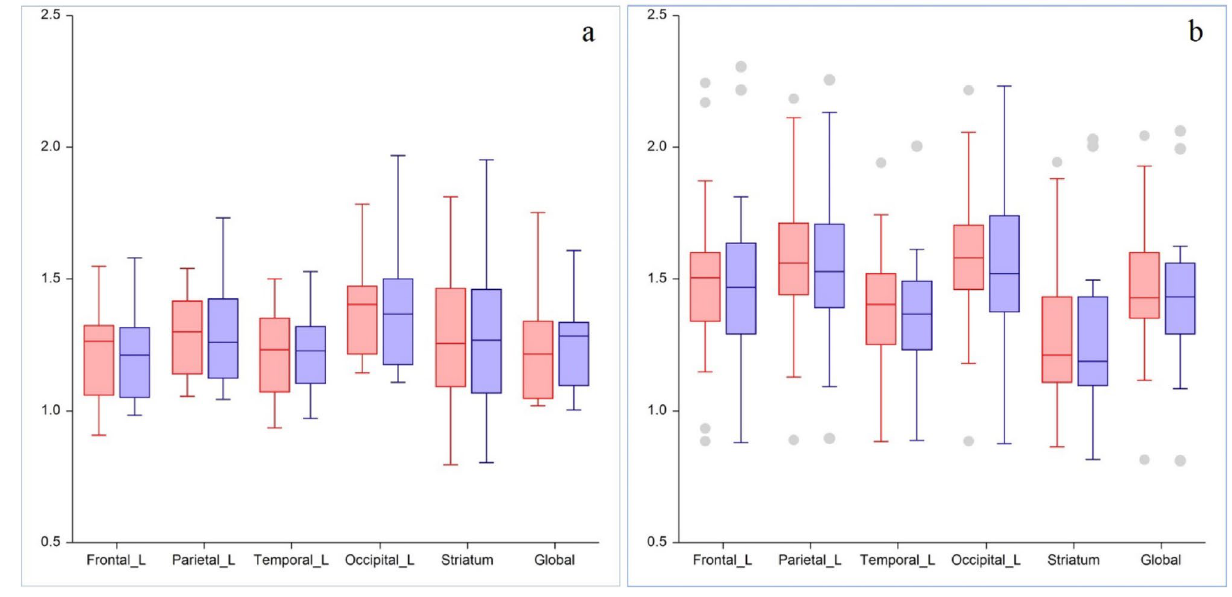
Figure 3. Comparison of the regional mean SUVR in the PET 20m (light blue) and sPET 20m (light red) images of the internal validation dataset ( a , negative group; b , positive group). Similar values are shown between PET 20m and sPET 20m images.